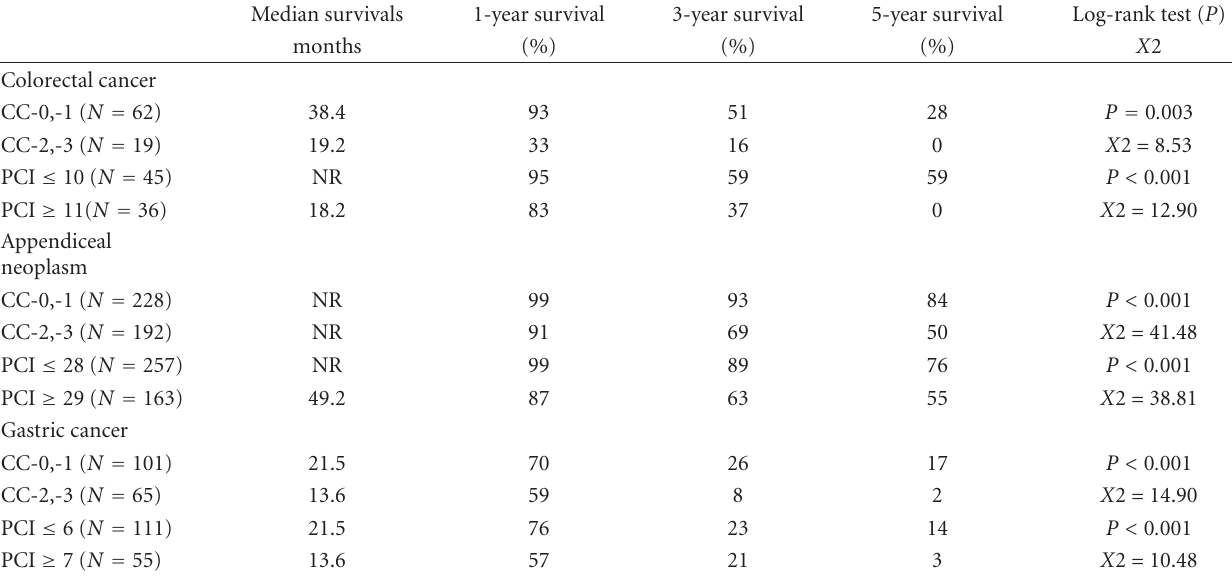
Table 4: Survival after CRS in terms of CC score and PCI